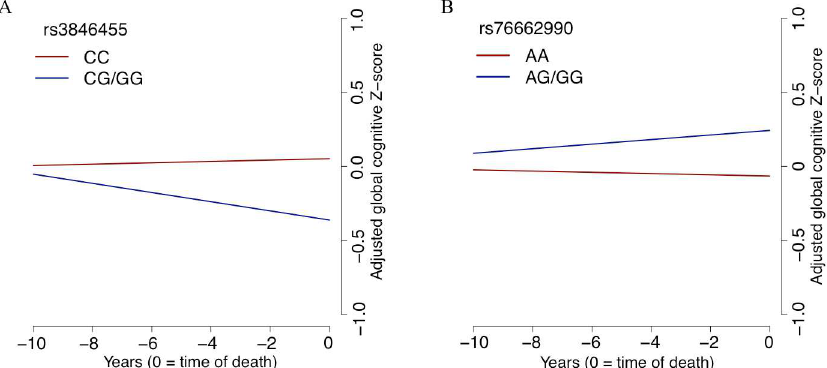
Fig 4. The slope of global cognitive decline by genotype. The averageslope of globalcognitivedeclineof individuals with a certain genotypeis shown, after adjustingfor pathologyand demographics. In both panels, the x -axis reports years before the participant’s death, and the y -axis presents pathology-adjusted global cognition( z- score,derived from baselinemean and standarddeviation).The slope is the pathology-adjusted residual slope of globalcognitivedecline, and the intercept represents mean residualcognition.(A) All Religious Orders Study and Rush Memory and Aging Project participants are partitionedby their genotypeat rs3846455 in the UNC5C locus. Cognitionis declining faster for participants with one or two copies of the minor allele (blue line) than for individuals who are homozygous for the major allele(red line). (B) The results for participants partitionedby rs76662990genotype, near the ENC1 locus. Here, the presenceof the minor alleleis protective againstpathology-adjustedcognitivedecline. Of note, we groupedparticipants who were homozygotes for the minor alleletogether with the heterozygotes in this plot, as homozygotes were rare for both